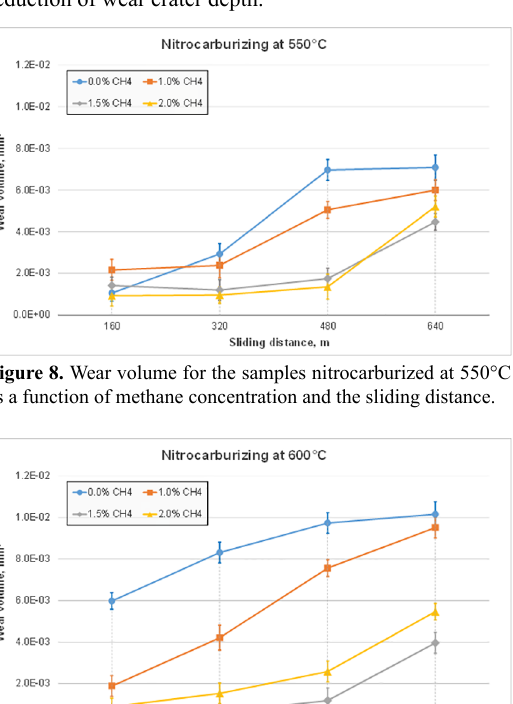
Figure 6. Wear craters for the samples nitrocarburized at 550°C.